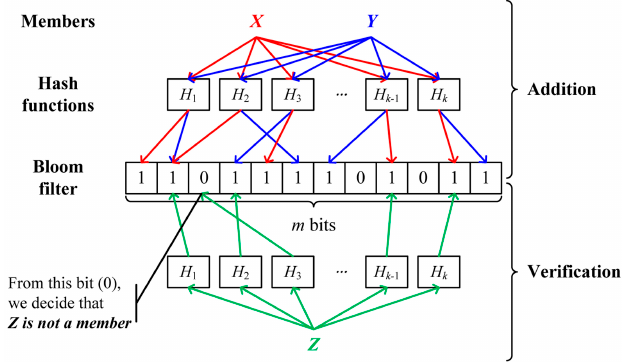
Figure 4. An example of the Bloom filter.